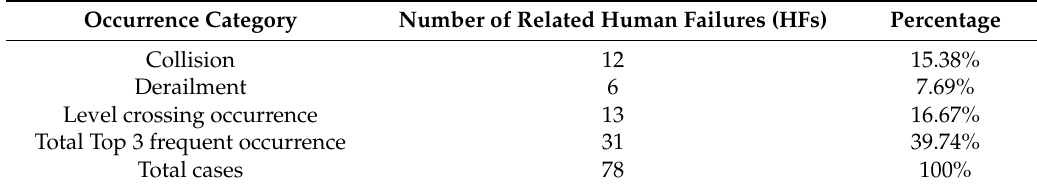
Table 2. Numbers and percentages of train accidents based on Human failure (HF).